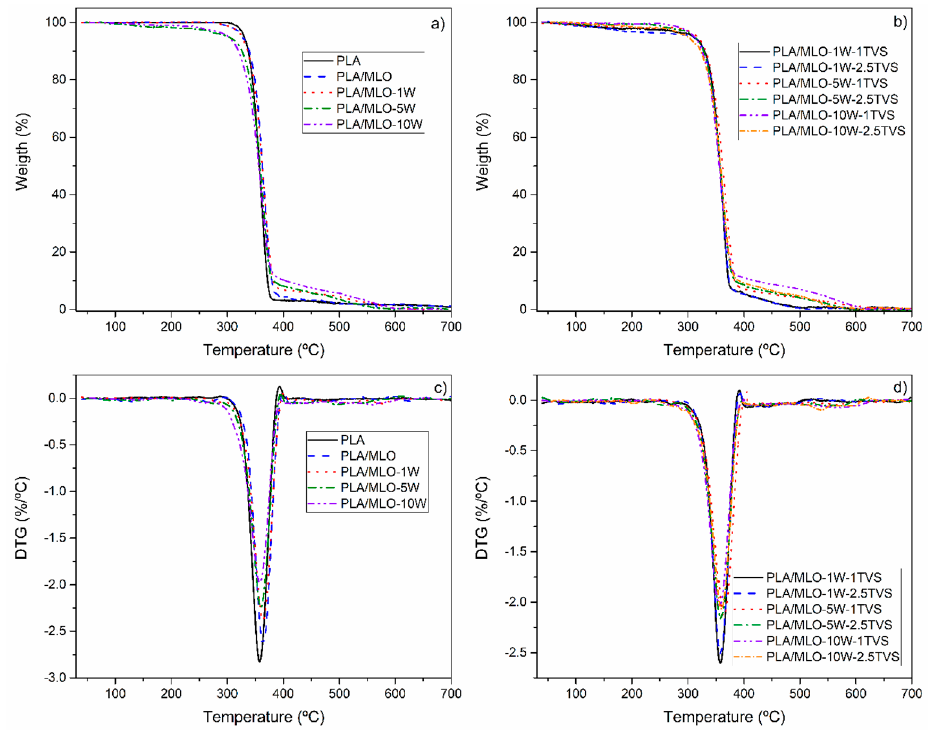
Figure 10. Thermogravimetric (TGA) and derivative thermogravimetric (DTG) curves: ( a ) TGA and ( c ) DTG of PLA, PLA/MLO, and untreated wool composites; ( b ) TGA and ( d ) DTG of TVS wool-treated composites.